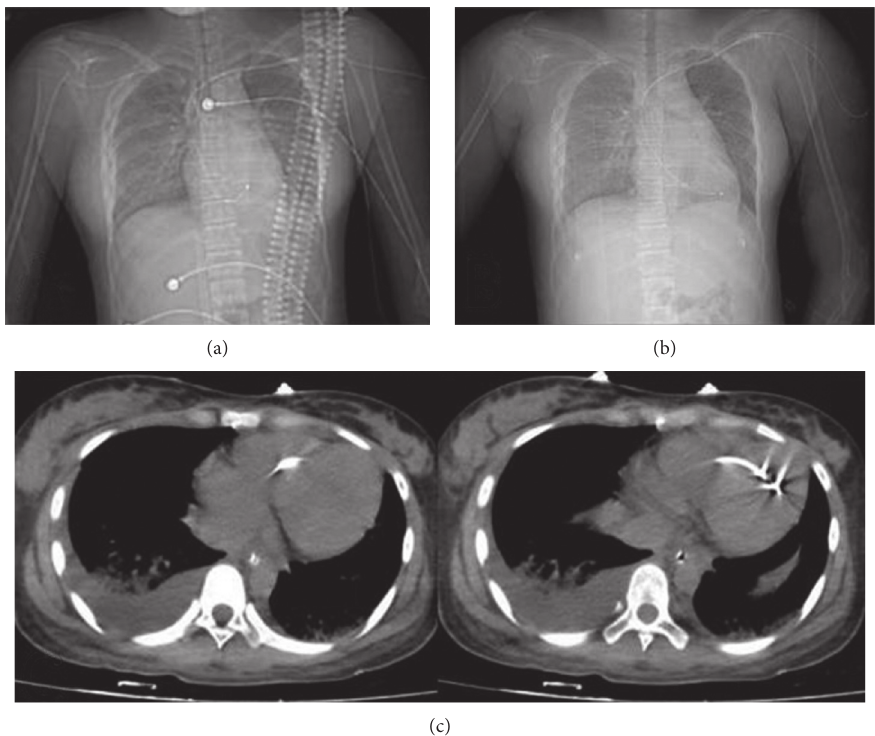
Figure 2: CT image of the lead penetrating the interventricular